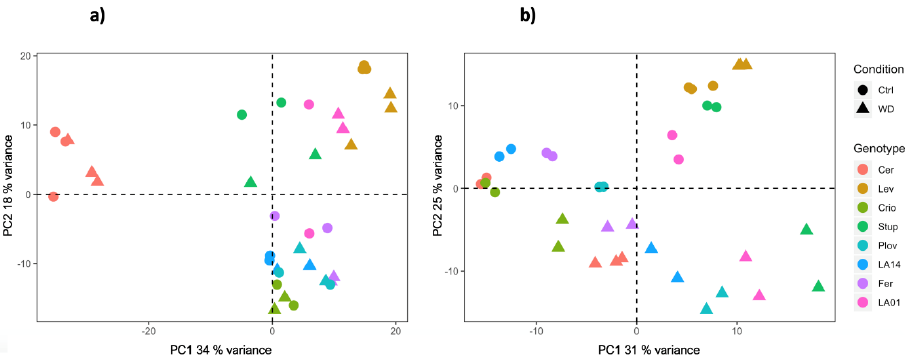
Figure 2. PCA plot of the normalized read counts in fruit ( a ) and leaf ( b ) samples, grown in control or WD conditions.